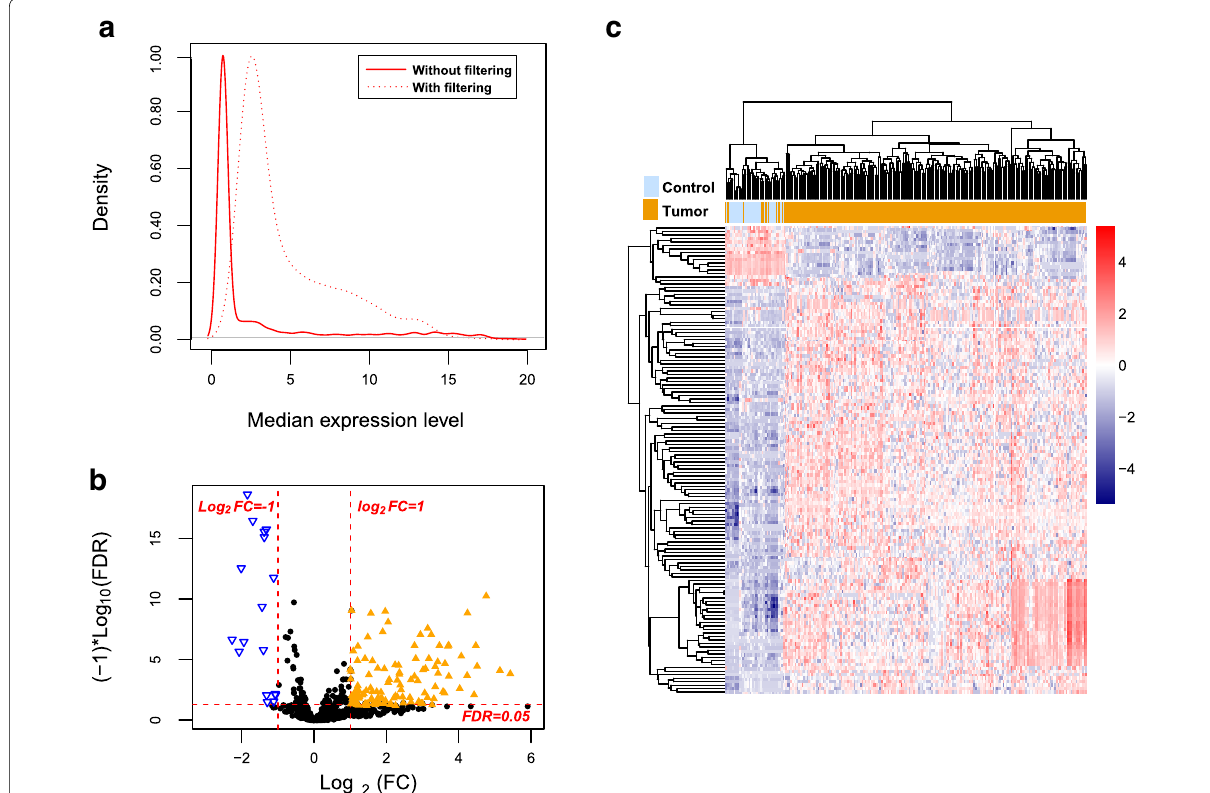
Fig. 1 a The density distribution curve of miRNA expression values before and after filtering. b Volcano map. Orange triangle, blue triangle, and black dots indicate genes are up-regulated, down-regulated, and non-significant differentially expressed miRNAs, respectively. c A bidirectional hierarchical clustering map based on 134 DEGs. Blue and orange sample bars represent normal control samples and tumor